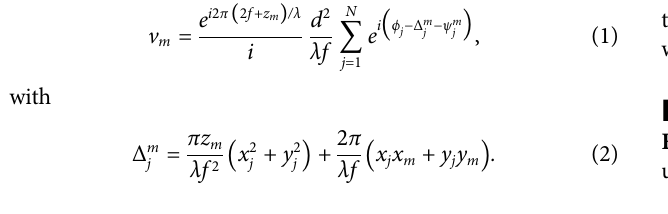
Figure 4 is an illustration of the holographic optical tweezers system